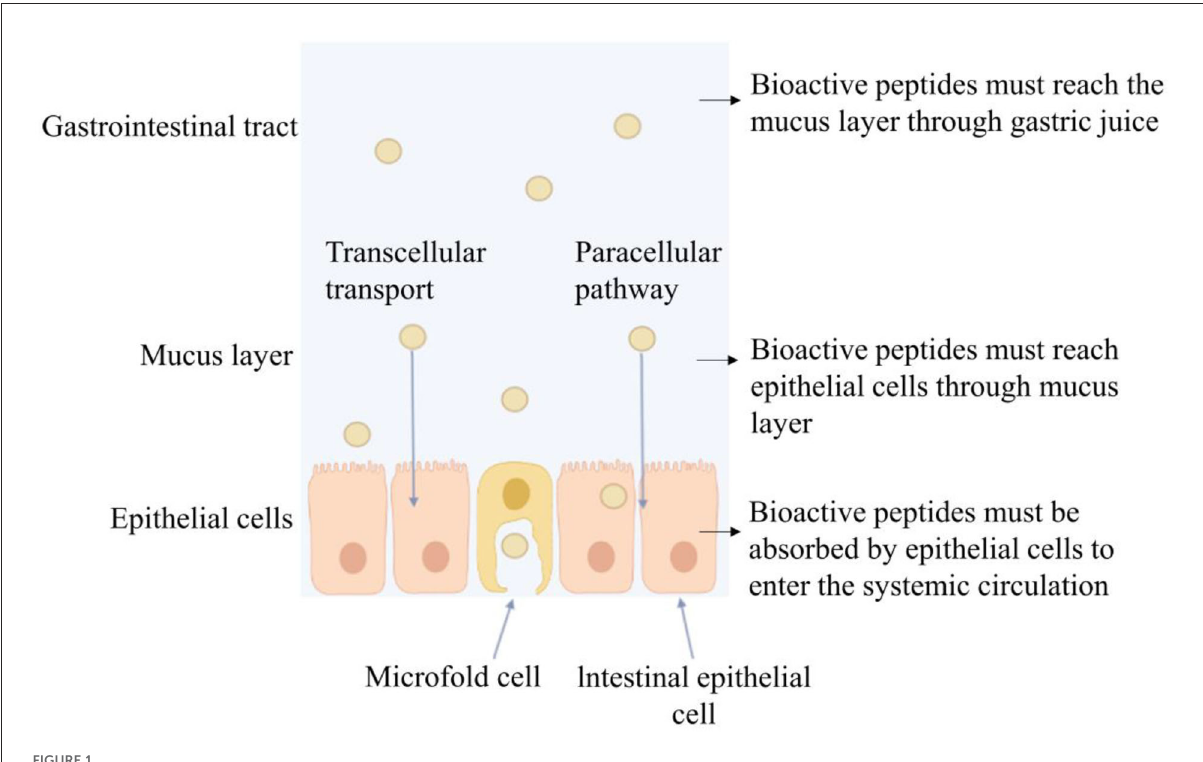
FIGURE1 Three barriers to bioactive peptide